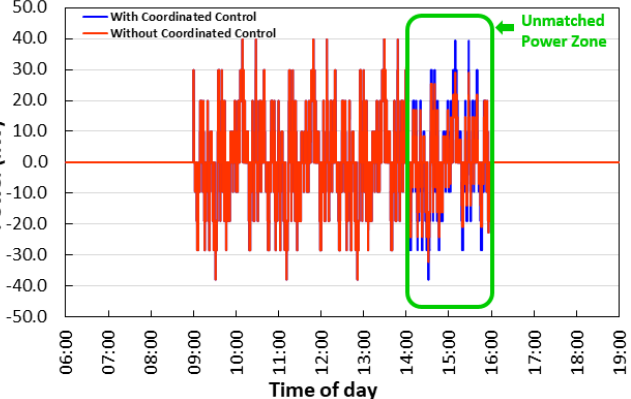
Figure 17. Simulink-based simulation of the total V2G power flow for PFC operation with or without the proposed coordinated control algorithm with 5 EVs.